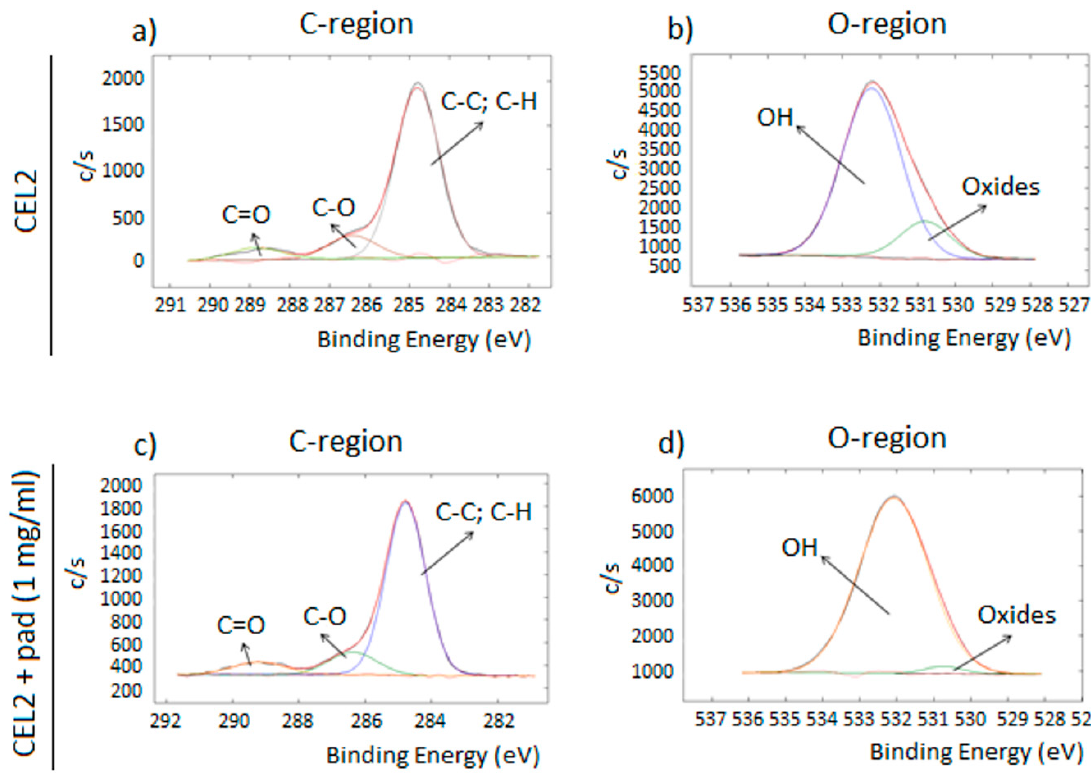
Figure 1. High resolution XPS spectra of ( a , c ) carbon (C-region) and ( b , d ) oxygen (O-region) for bare